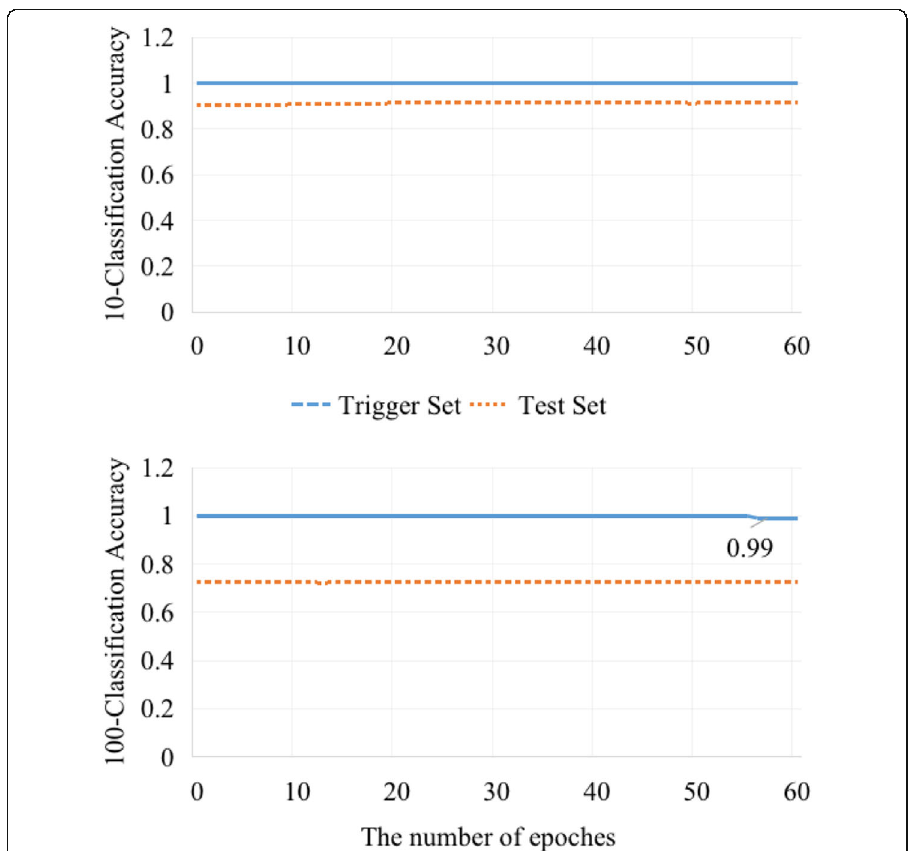
Fig. 3 Transfer learned watermarked network classification accuracy for the owner ’ s trigger set and test set. The data in the figure is the average of five experiment